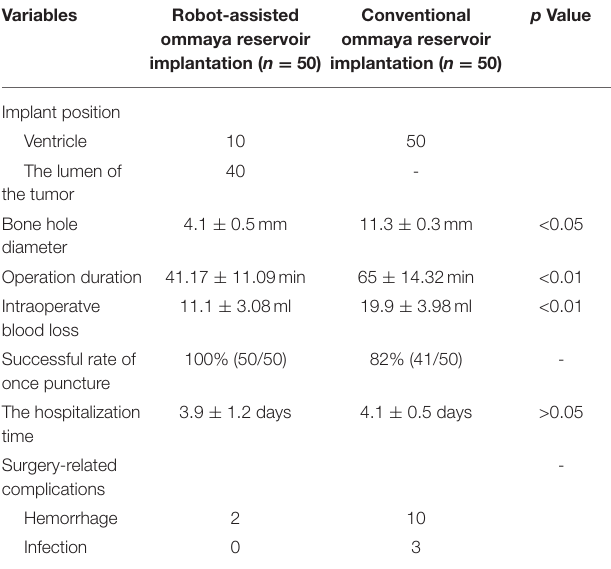
TABLE 2 | Comparison of clinical characteristics in the robot-assisted and conventional surgery groups.